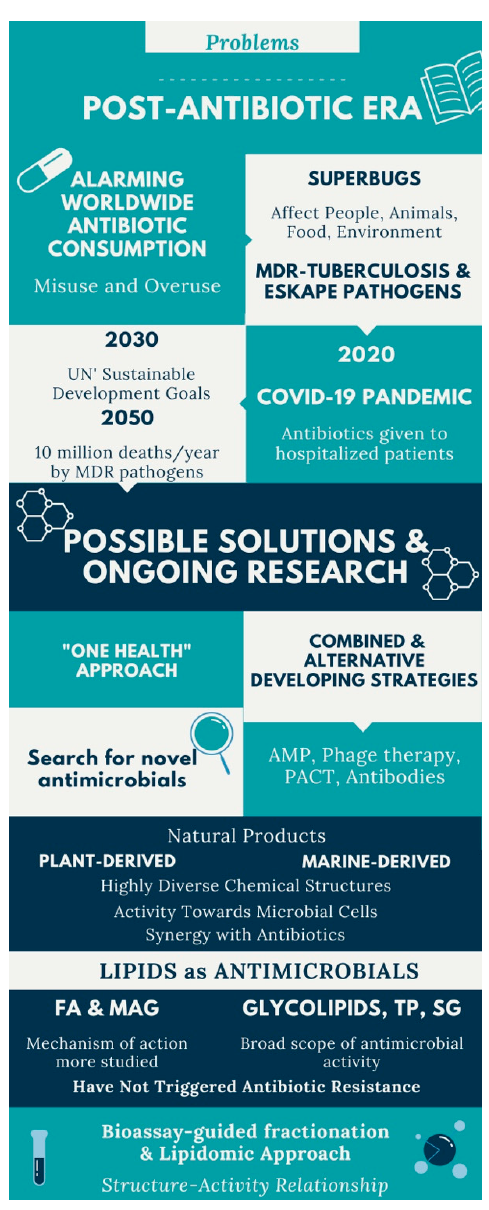
Figure 1. Infographic of the actual state-of-the-art on antibiotic resistance and search for novel antimicrobials, as natural product-derived lipids. Abbreviations: MDR, multidrug resistant; UN, United Nations; AMP, antimicrobial peptides; PACT, photodynamic antimicrobial chemotherapy; FA, fatty acids; MAG, monoacylglycerols; TP, terpenoids; SG, steroidal glycosides.